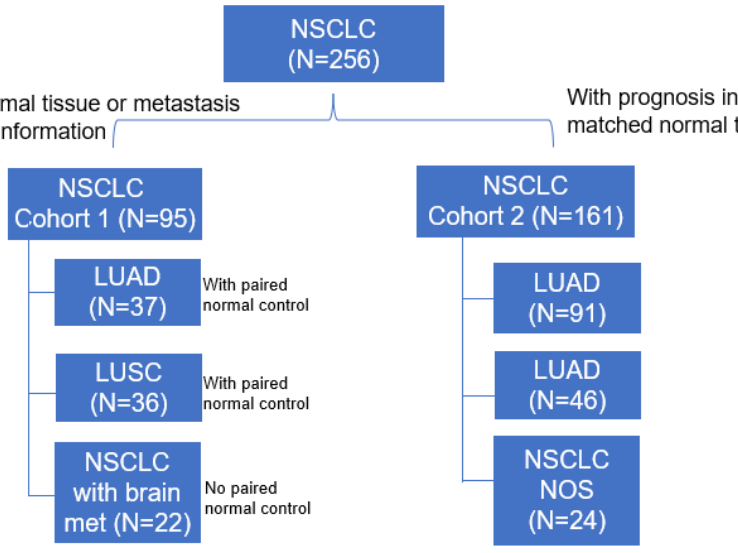
Figure 1. Study flow chart. The distribution of lung cancer types of TMA is illustrated. Abbrevia- tions: NSCLC, non-small-cell lung cancer; LUAD, lung adenocarcinoma; LUSC, lung squamous cell carcinoma; NOS, not other specified.